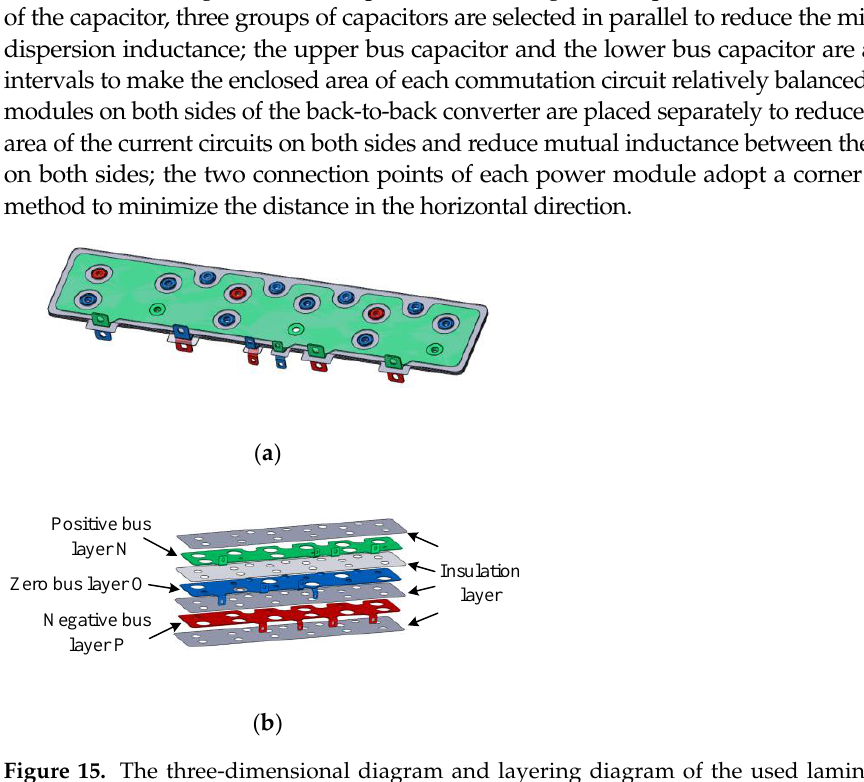
Figure 15. The three-dimensional diagram and layering diagram of the used laminated busbar. ( a ) Three-dimensional map. ( b ) Layered schematic. Based on the above points, the prototype design based on the laminated busbar is shown by the exploded view in Figure 16.